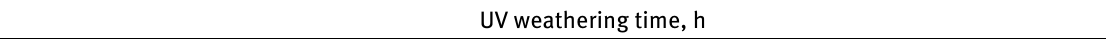
UV weathering time, h